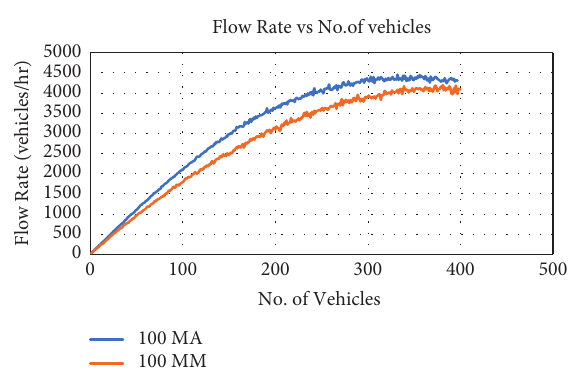
Figure 17: Flow rate vs. no. of vehicles fundamental diagrams for different compositions of 100 percent MA vs. 100 percent